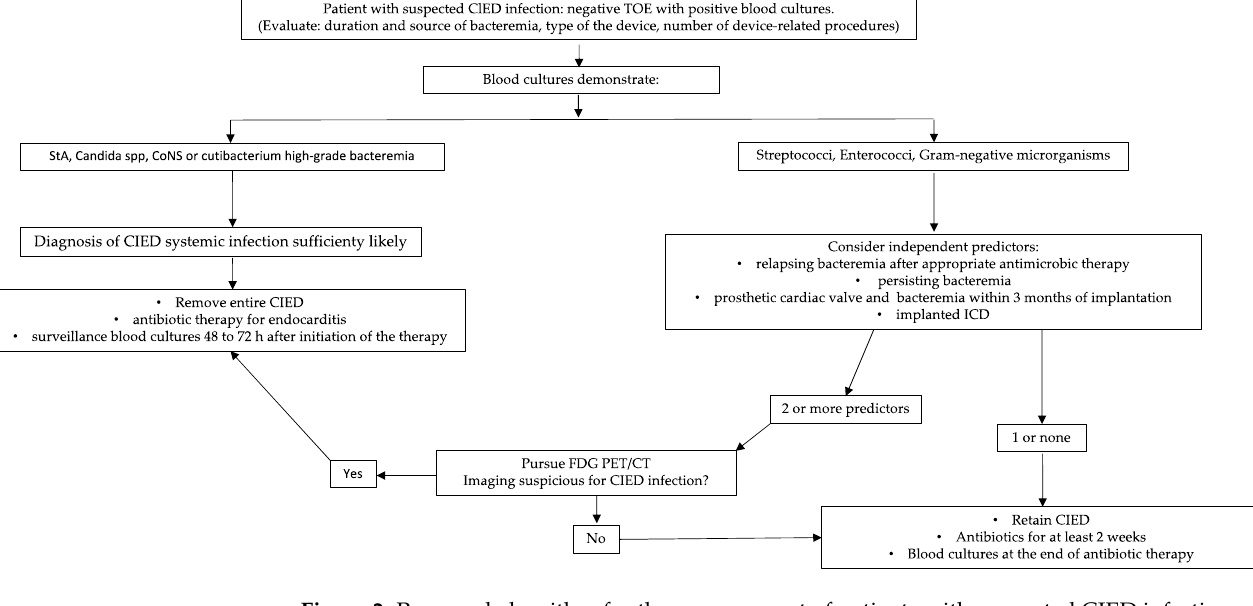
Figure 2. Proposed algorithm for the management of patients with suspected CIED infection with negative TOE and positive blood cultures. CIED: cardiovascular implantable electronic device; TOE: trans-oesophageal echocardiography; StA: Staphylococcus aureus; CoNS: coagulase-negative Staphylococci; ICD: implantable cardiac defibrillator; FDG PET/CT: Fluorine-18-fludeoxyglucose (18F-FDG) positron emission tomography/computerised tomography.